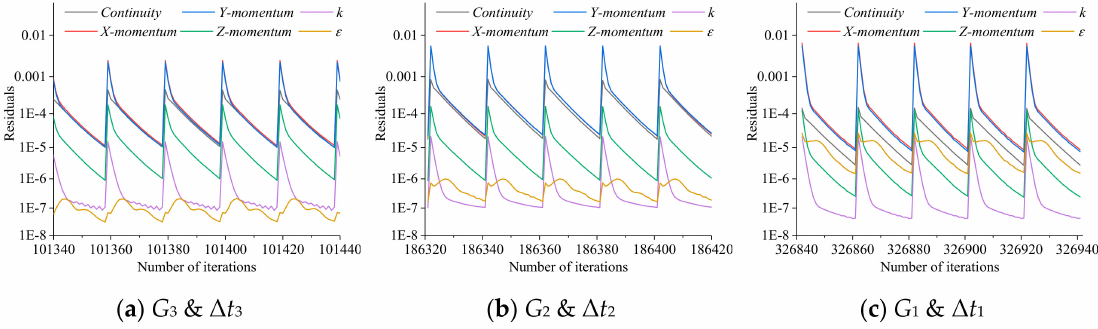
Figure 8. Example of residuals in the last few time steps before convergence, Q = 0.42 m 3 /s.